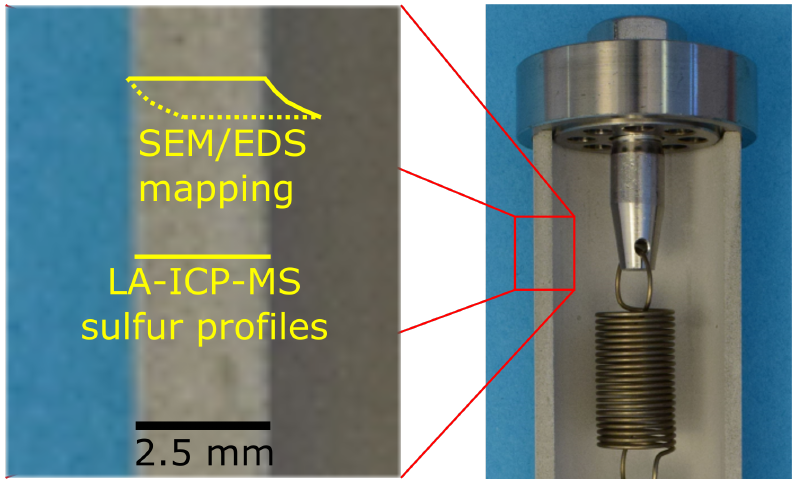
Figure 3. Schematic representation of the measurement ranges for SEM/EDS mapping and LA-ICP- MS sulphur profile